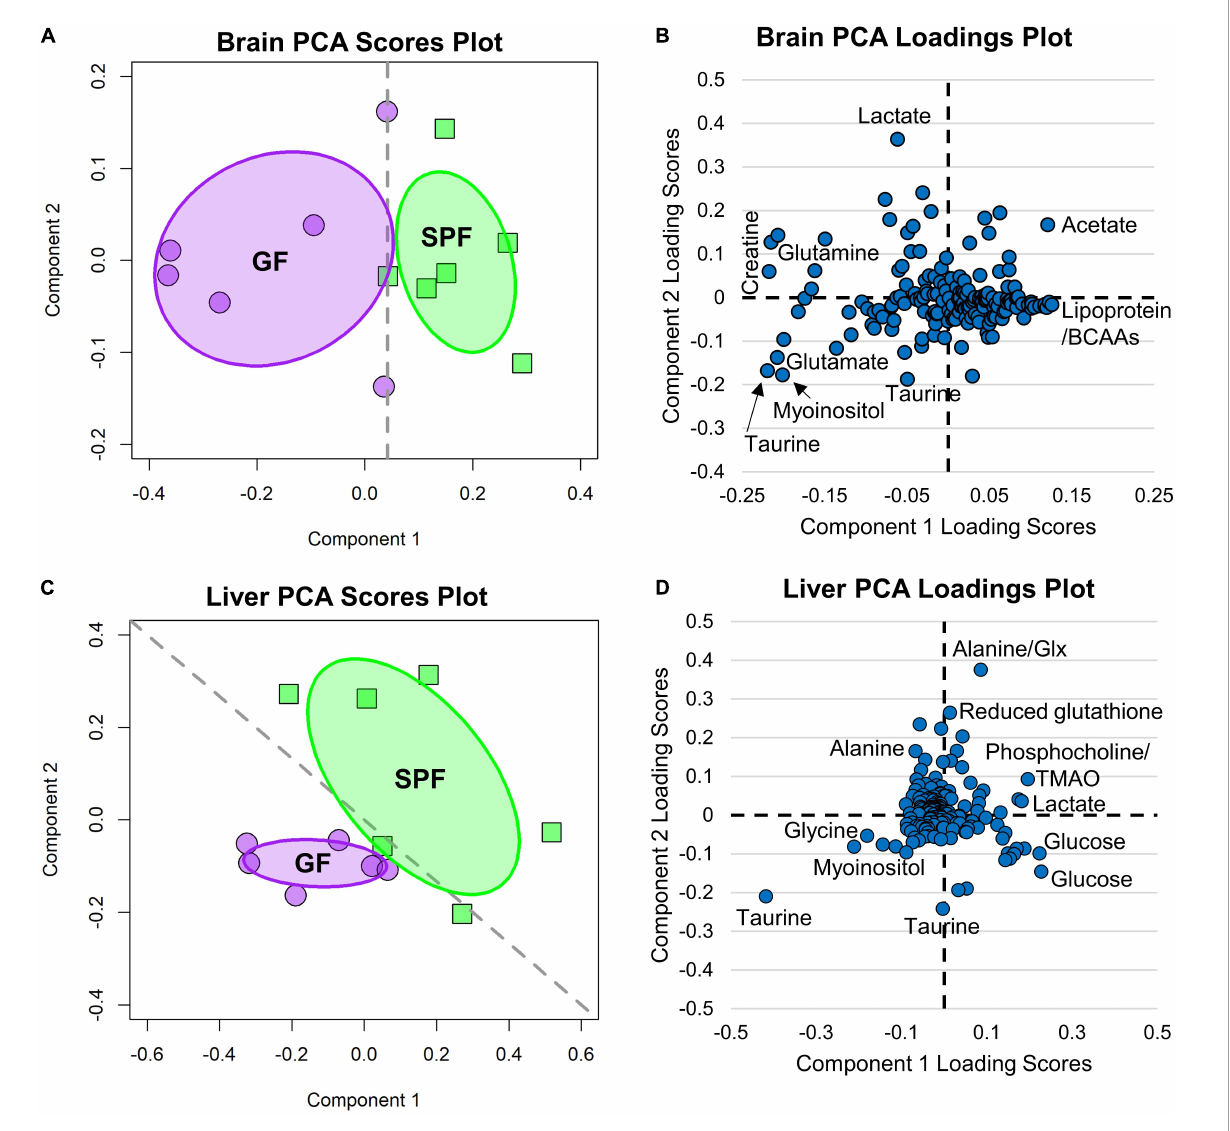
FIGURE2 PCA score plots comparing the GF and SPF liver and brain metabolome. Purple data points are from GF ( n = 6) and green from SPF ( n = 6) mice. (A) Brain PCA plot; P1 = 71%, P2 = 11% and (B) corresponding loadings plot. (C) Liver PCA plot; P1 = 43%, P2 = 22% and (D) corresponding loadings